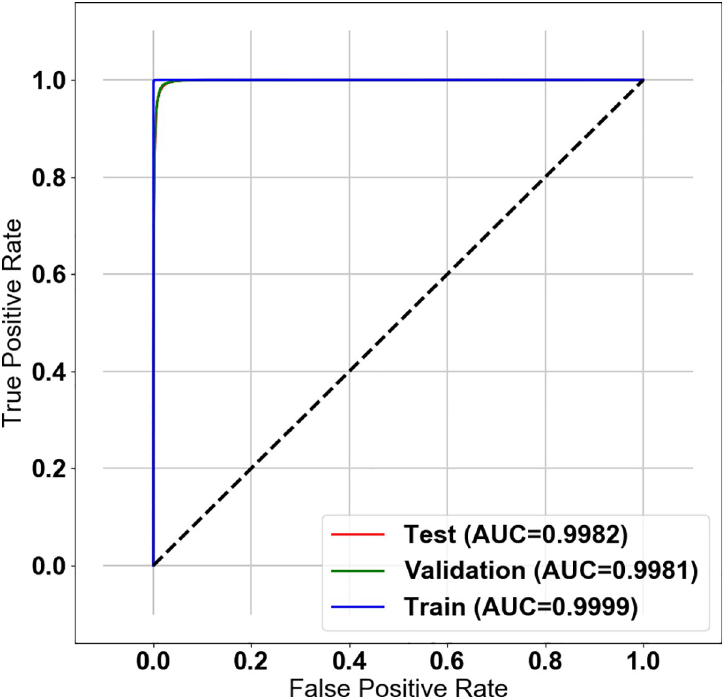
Fig 4. Receiver operating characteristic curve of the AI for binary classification. The receiver operating characteristic (ROC) curve of AI for detection of significant images: Area under the curves (AUCs) were 0.9982, 0.9981, and 0.9999 for test, validation, and training set images, respectively. ROC curve and AUCs shown that the training model is well fitted to all of training images as well as there is little degradation of validation and testing performance from the training